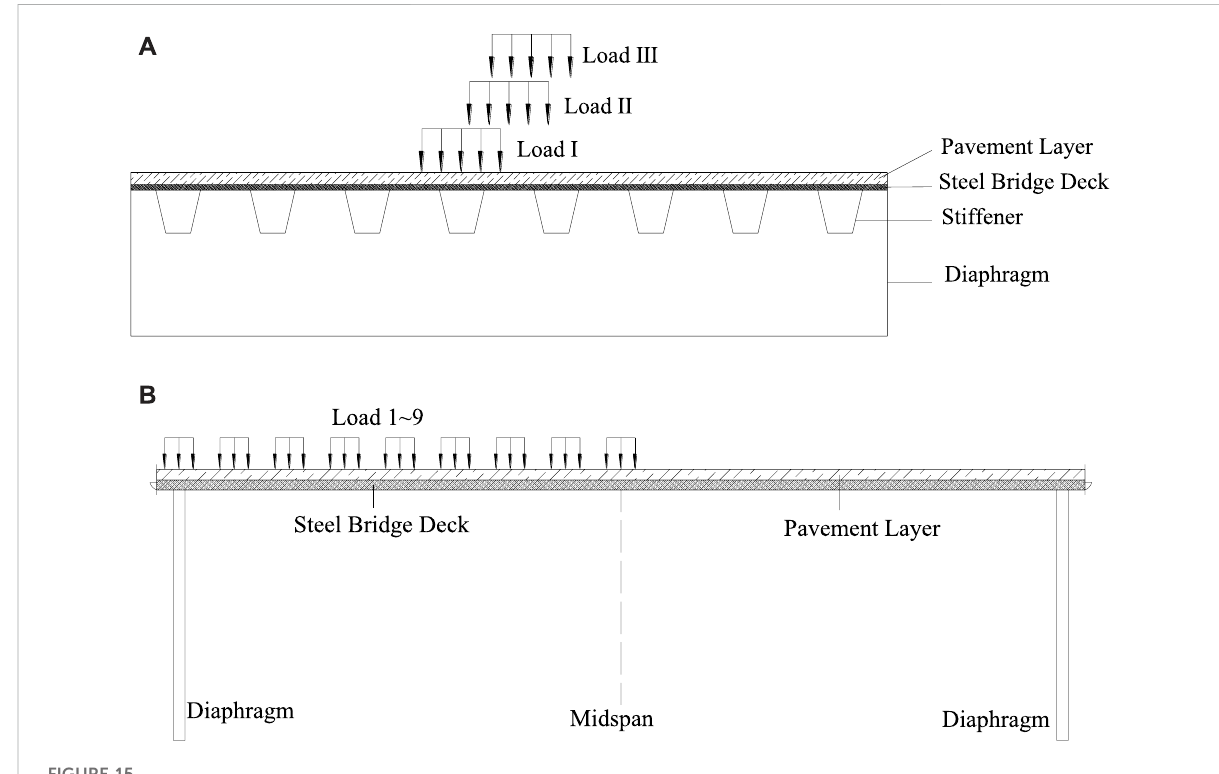
FIGURE 15 Load distribution on the pavement structure. (A) Transverse load distribution; (B) Longitudinal load distribution.